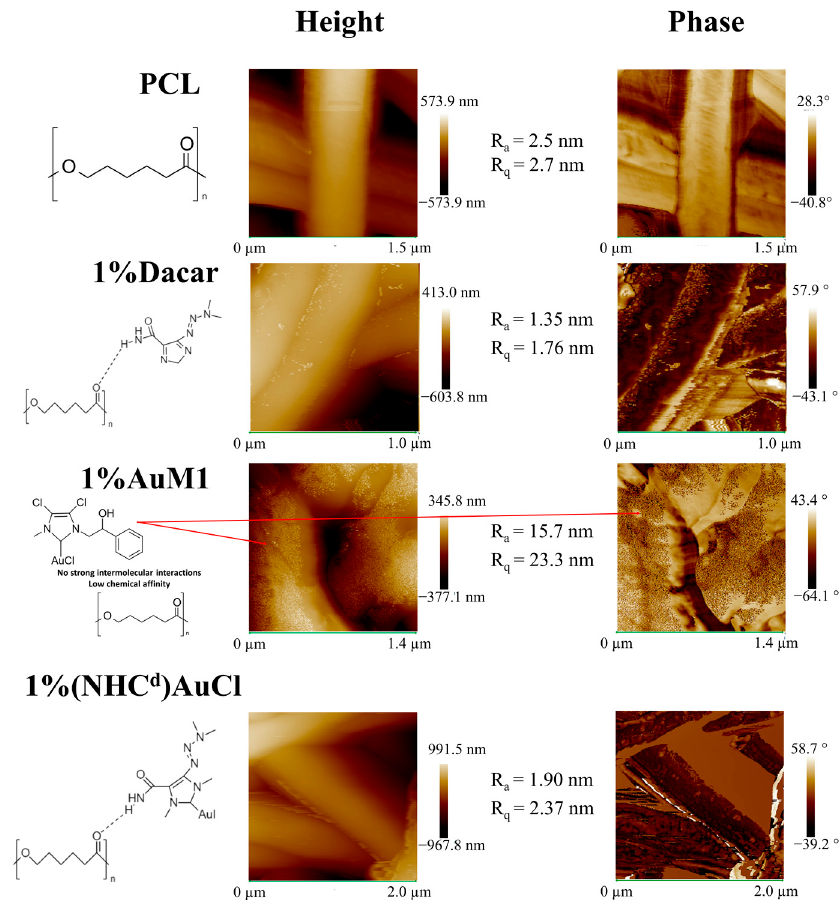
Figure 5. AFM images of the unfilled and filled membranes.